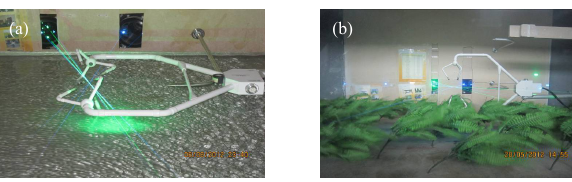
Figure 8. Examples of the test surfaces of (a) water, and (b) trees.